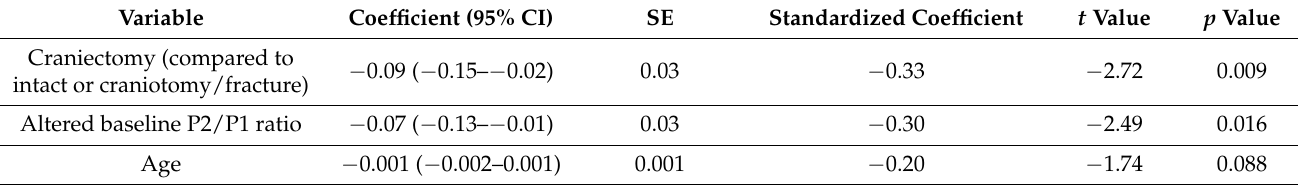
Table 3. Multivariable linear regression for P2/P1 variation (after compression—baseline).